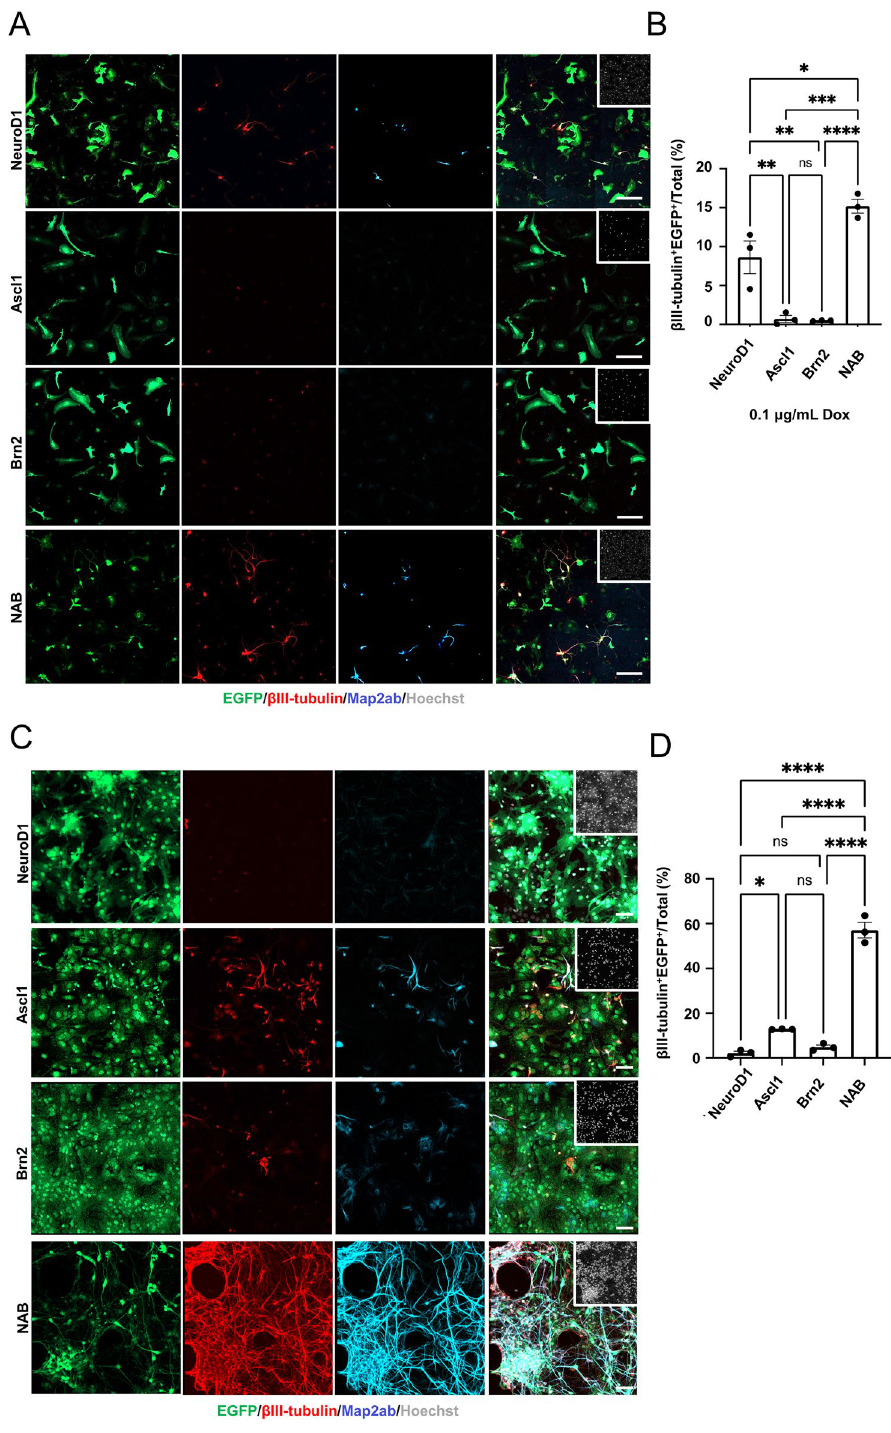
Figure 4. Optimal combinations of RFs increase neuronal reprogramming efficiency. ( A ) Representative images of staining for EGFP (green), βIII-tubulin (red), and Map2ab (cyan) in microglia infected with EGFP- and M2rtta-viruses together with NeuroD1-, Ascl1-, Brn2-, or NAB-viruses at 7 dpt. Dox, 0.1 μg/mL. Scale bars, 100 μm. ( B ) Quantification of the βIII-tubulin + and EGFP + cells in (A) (n = 3). * p < 0.05 by unpaired Student’s t test. ( C ) Representative images of staining for EGFP (green), βIII-tubulin (red), and Map2ab (cyan) in NR-astrocytes (infected as in ( A )) at 7 dpt. Dox, 1 μg/mL. Scale bars, 100 μm. ( D ) Quantification of the βIII- tubulin + and EGFP + cells in ( C ) (n = 3). *** p < 0.0005 by unpaired Student’s t